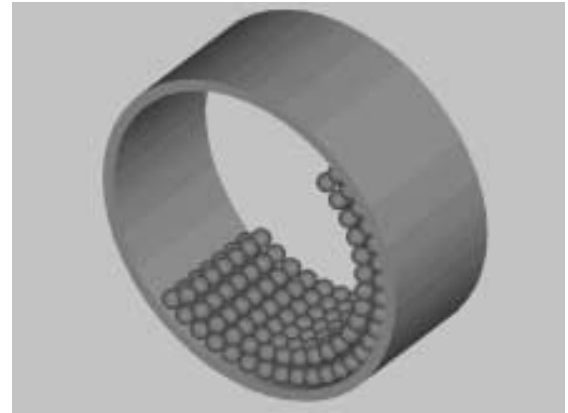
Fig. 6 Three-Dimensional Representation of a Shell Cycle. Fig. 8 Three-Dimensional Representation of the Surface Formed Between Contiguous Shells.